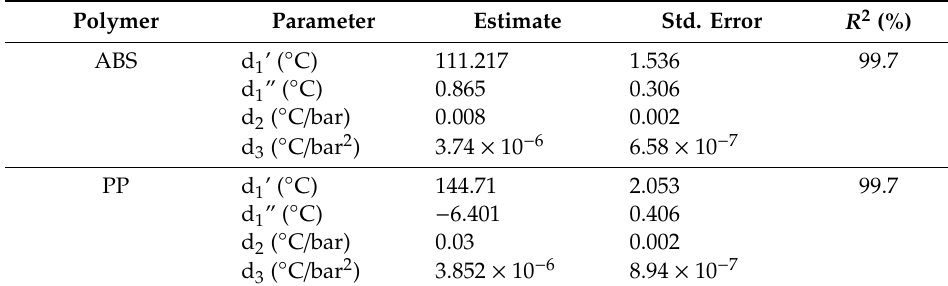
Figure 5. Experimental and calculated transition temperature of the amorphous Acrylonitrile-butadiene-styrene (ABS) ( a ) and the semi-crystalline polypropylene (PP) ( b ) as a function of the cooling rate. Table 1. Parameters for the transition temperature, T t , estimated by the quadratic polynomial regression model considering the cooling rate, Equations (35) and